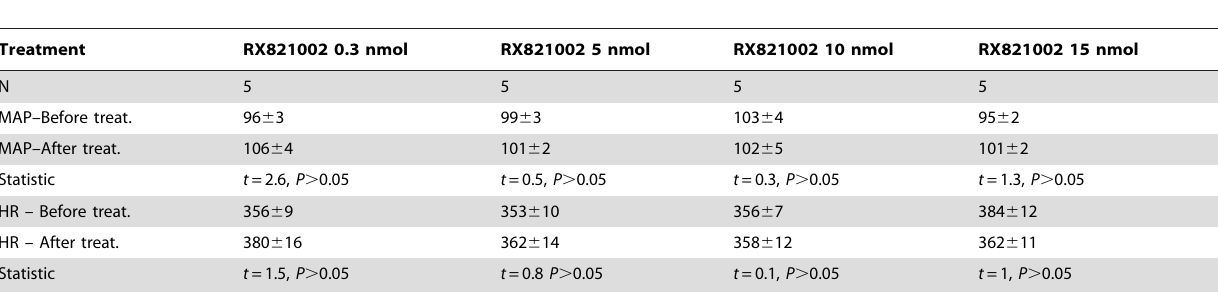
Table 2. Effect of bilateral microinjections into the IC of crescent doses (0.3, 5, 10 and 15 nmol/100 nl) of the selective a 2 - adrenoceptor antagonist RX821002 on mean arterial pressure (MAP) and heart rate (HR) baseline.